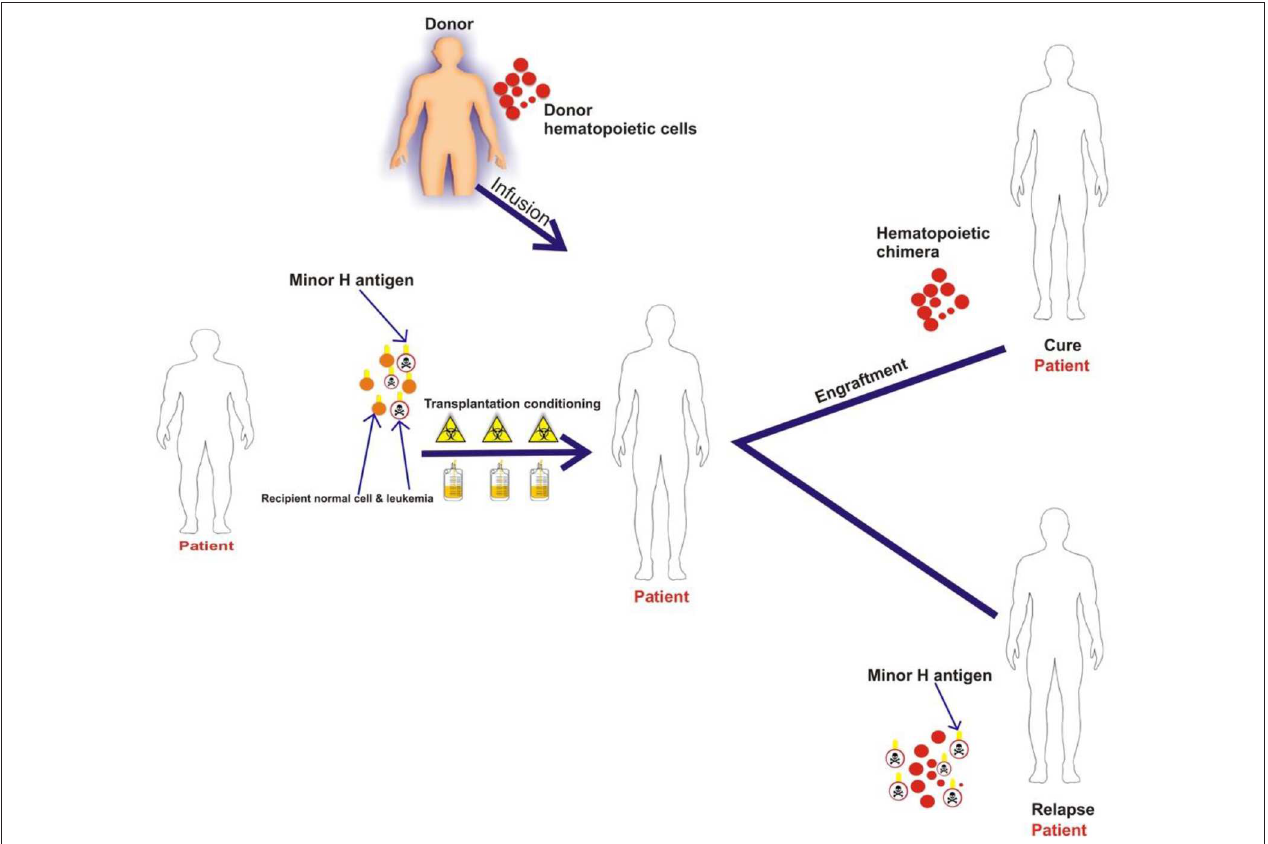
FIGURE 3 | The schematic illustrates that patient normal hematopoietic and leukemia cells with minor H antigens are eliminated by the transplant conditioning regimen and replaced with donor hematopoietic cells. Once full donor normal hematopoietic cell chimerism is achieved only recipient malignant hematopoietic cells present hematopoietic-restricted minor H antigens if disease persists or recurs following HCT. These minor H antigens serve as tumor-specific antigens for donor T